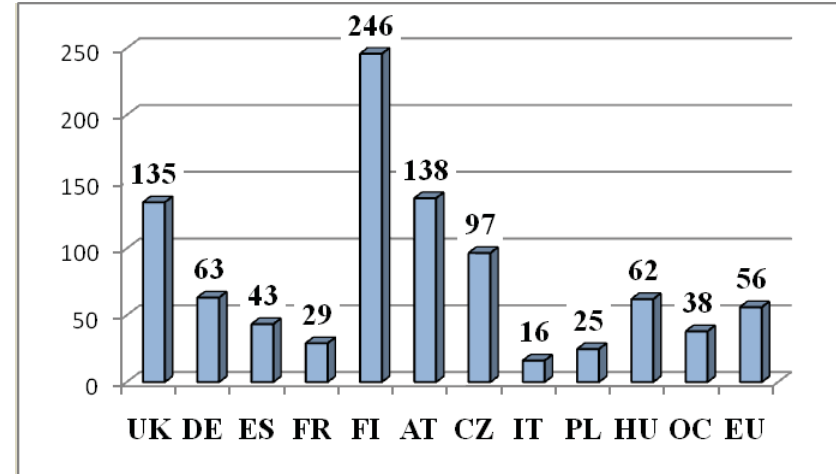
Fig. 1. Number of social economy enterprises per 10 thousand inhabitants in EU Abbreviated names of countries